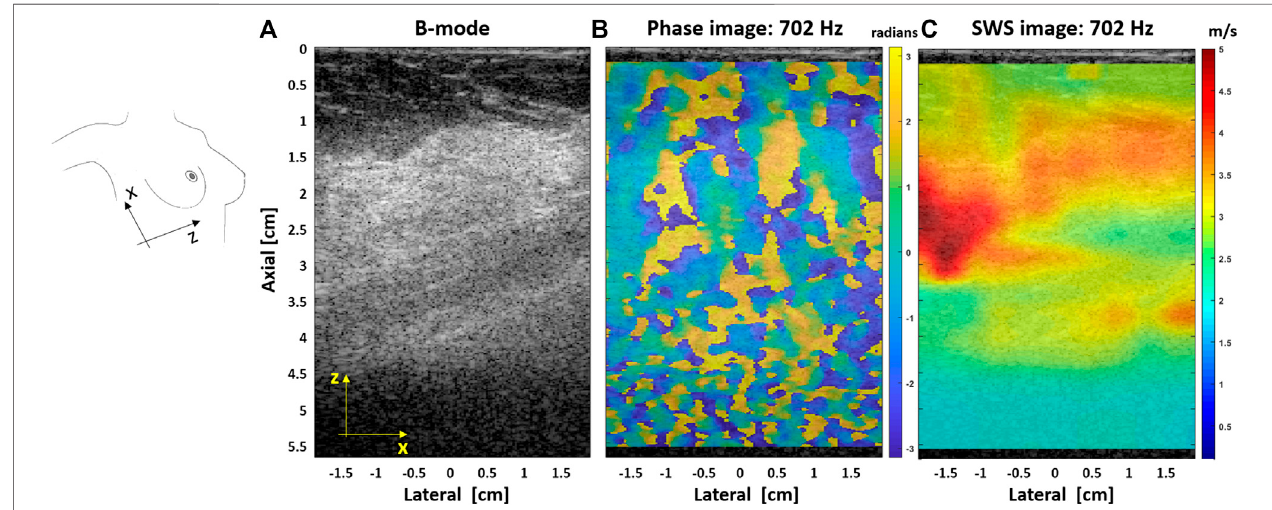
FIGURE 7 | (A) B-mode image for a patient with a dense breast tissue. (B) Extracted phase map pattern at 702 Hz; the random pattern indicates the different propagation directions of the shear waves generated with the vibration sources. (C) SWS image, superimposed on its corresponding B-mode image, obtained with the US-RSWE approach at a vibration frequency of 702